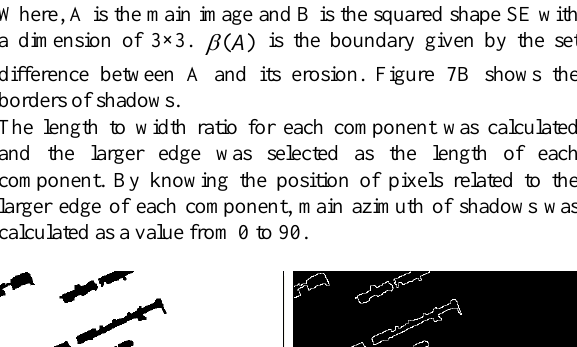
Figure 8. A. Subtracting main image from shadow-free image, B. Opening and closing operators were performed on (A) to eliminate extra objects, C. Final road networks from Hough transform